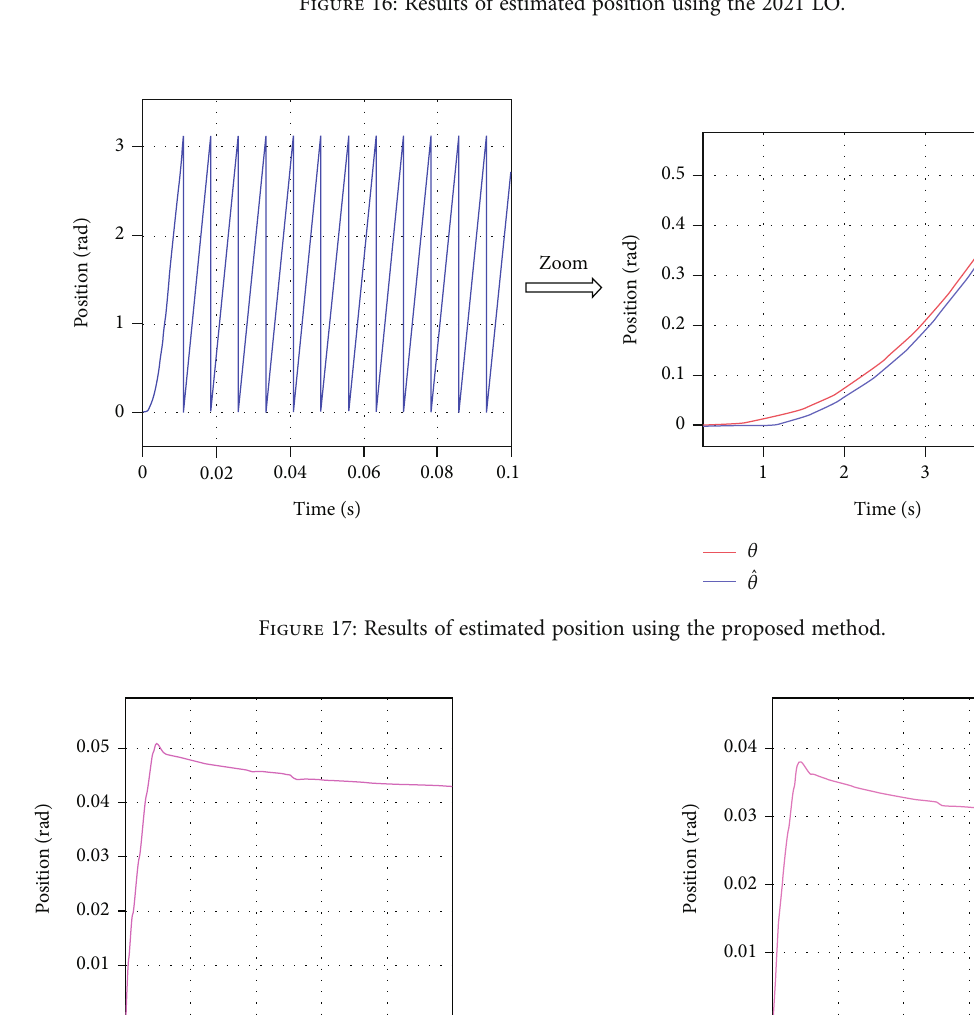
Figure 16: Results of estimated position using the 2021 LO.